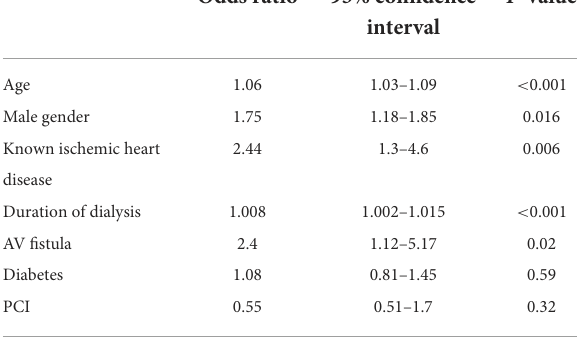
TABLE 4 Logistic regression analysis for